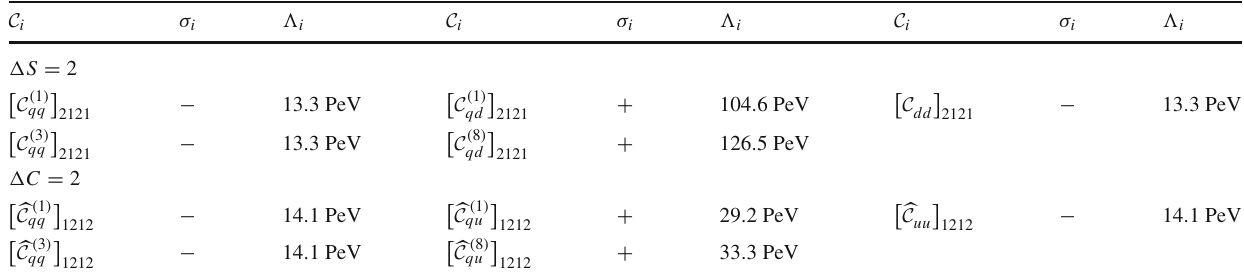
Table 2 Effective scales of SMEFT operators contributing to ε K and CP violation in D 0 - ¯ D 0 mixing, defined as in (25) and (31), respectively. These scales give an indication of the sensitivity to the individual oper-